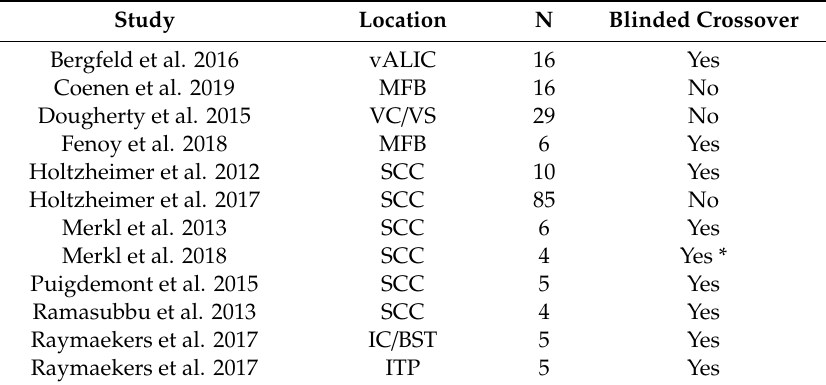
Table 1. Studies included in meta-analysis and meta-regression.